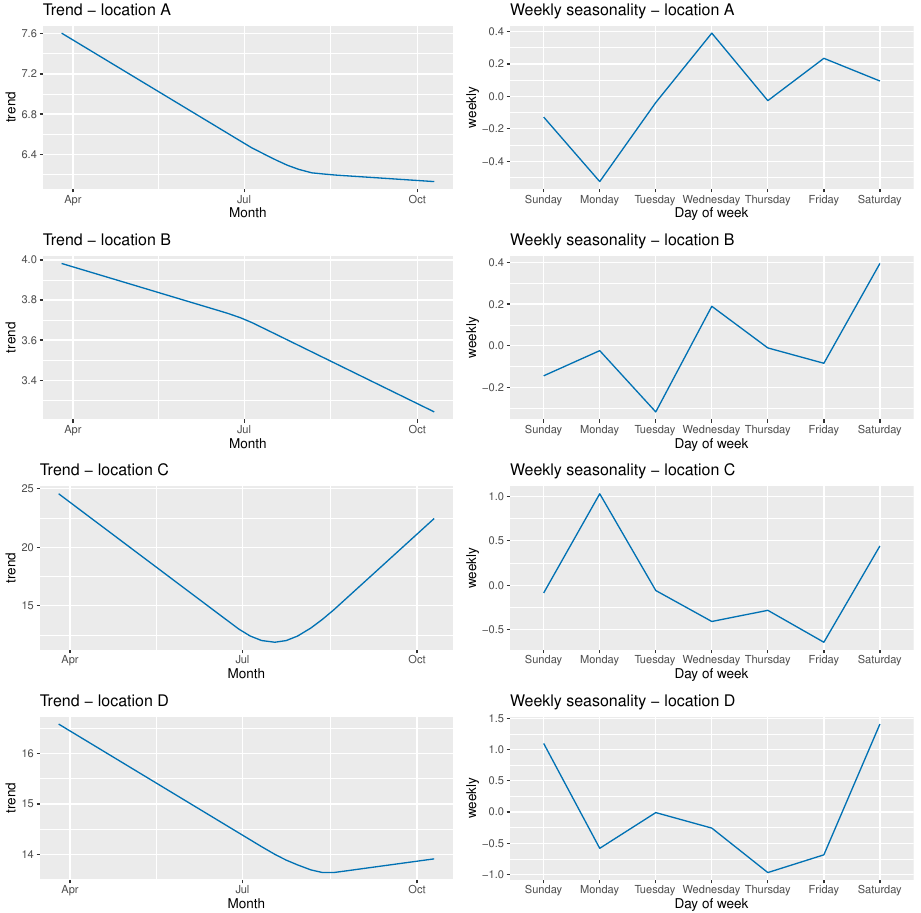
Figure 2. Decomposition of energy consumption time-series for each location. Trend and weekly seasonality are